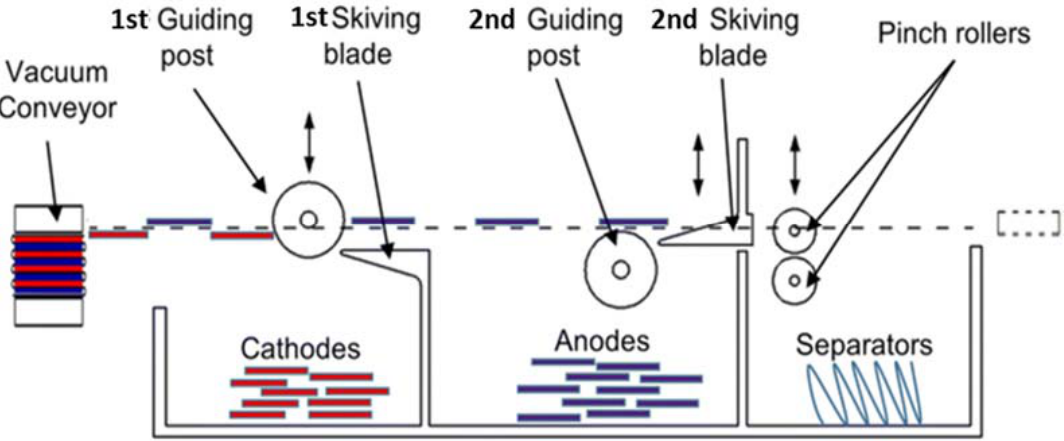
Figure 6. The prototype for automatic sorting of LIB pouch cell [96]. (3). Separation